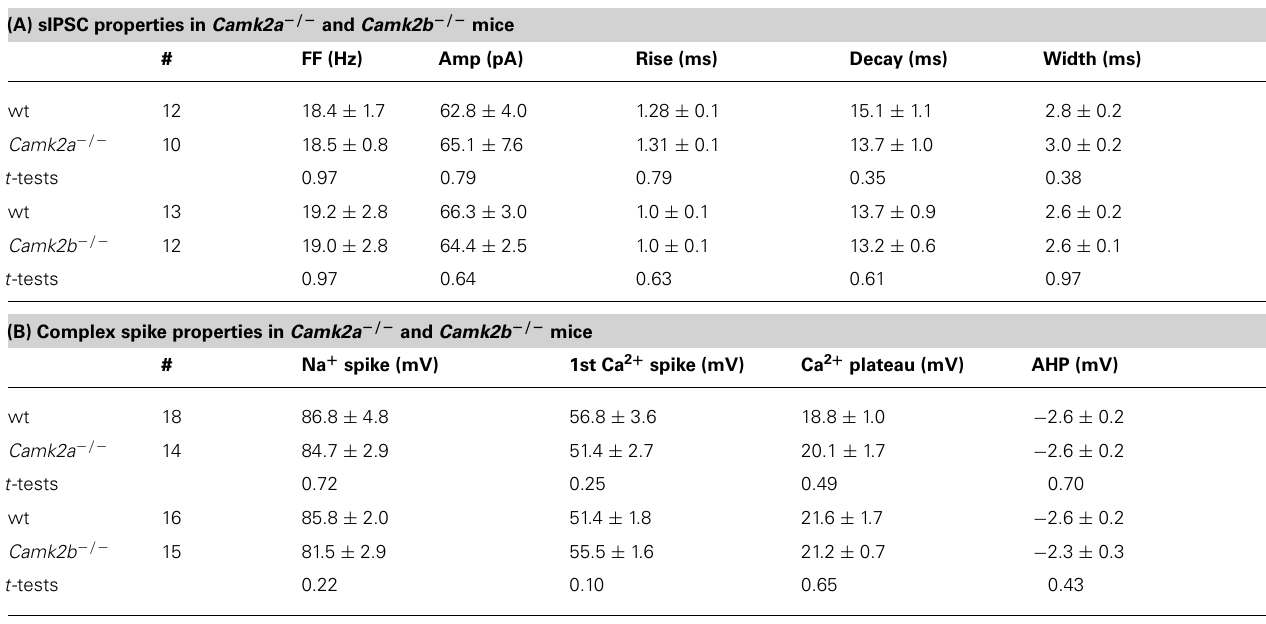
Table 1 | Normal spontaneous IPSC properties in Camk2a − / − and Camk2b − / − Purkinje